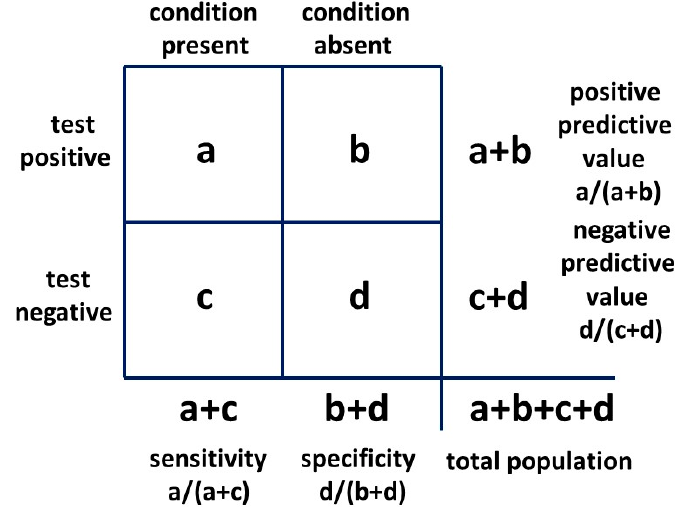
Figure 5. Bayesian 2 × 2